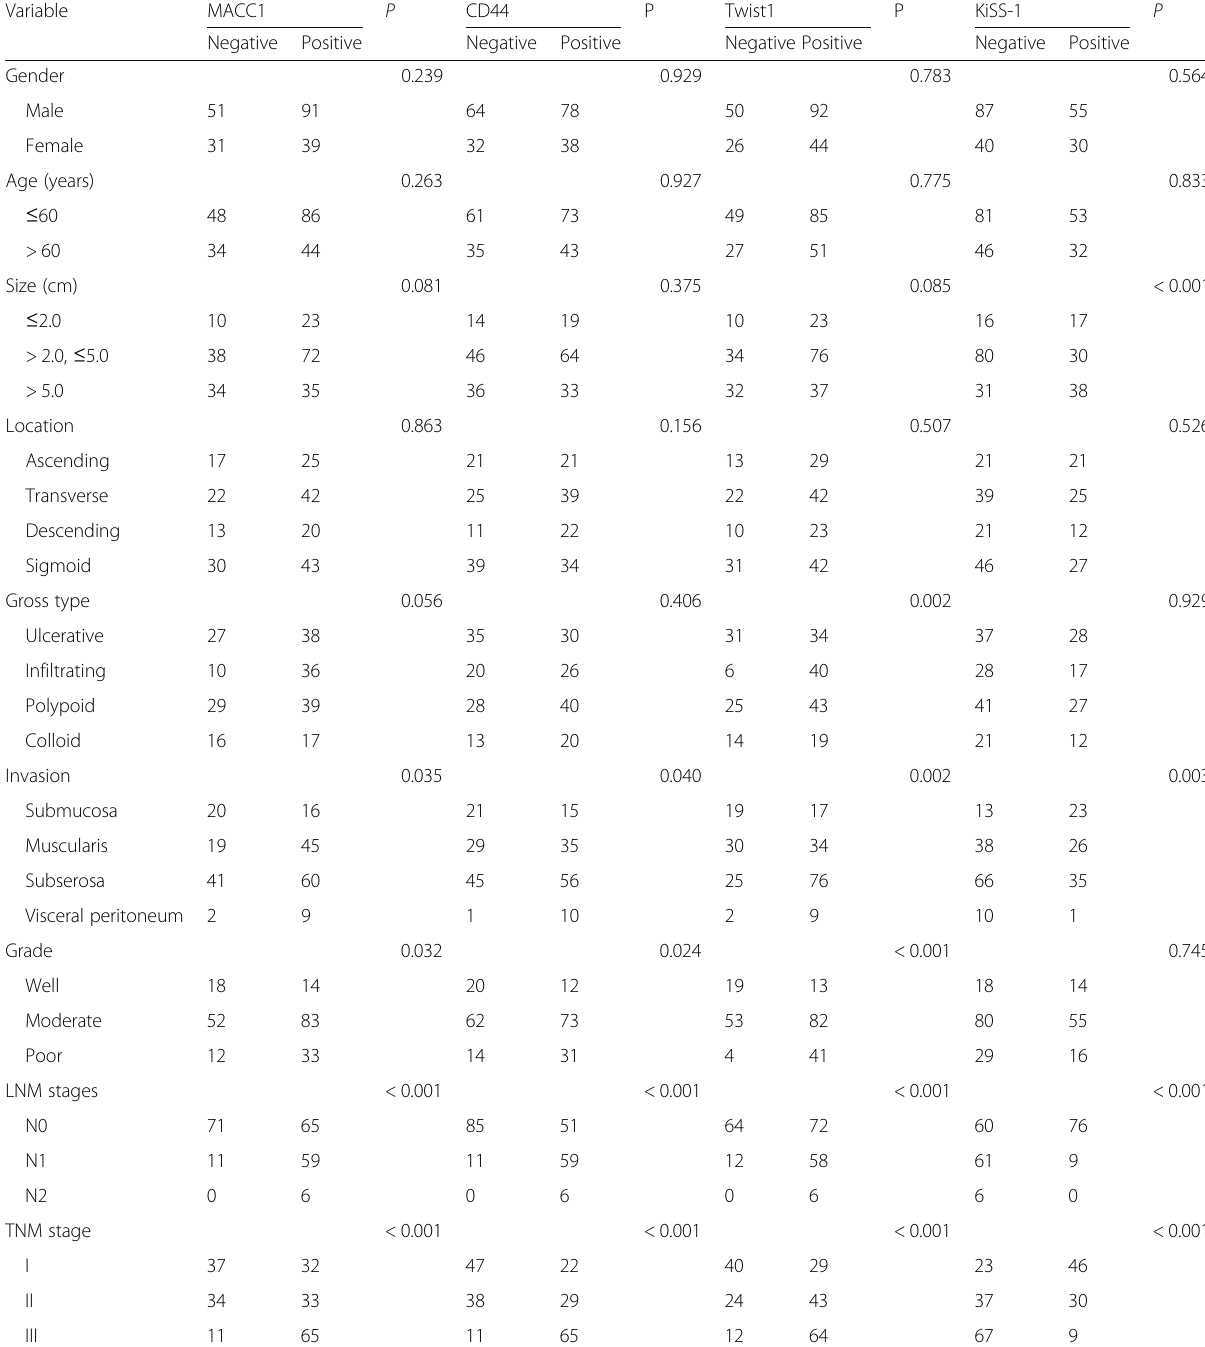
Table 2 The correlation between MACC1, or CD44, or Twist1, or KiSS-1 and clinicopathological characteristics in colon adenocarcinoma